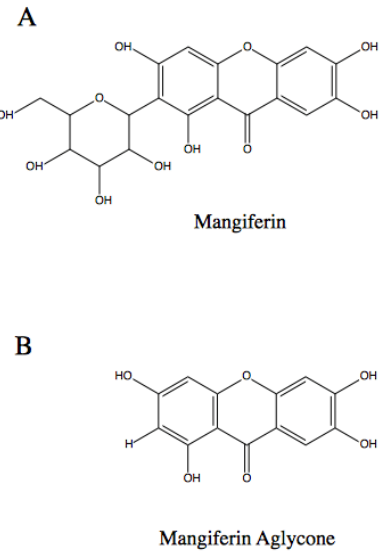
Figure 1. The molecular structure of: ( A ) mangiferin [45]; and ( B ) mangiferin aglycone [46].